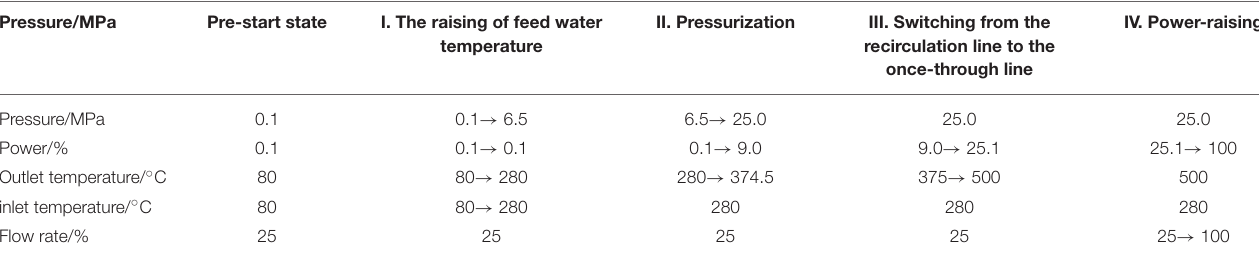
TABLE 2 | Sliding pressure startup procedure.